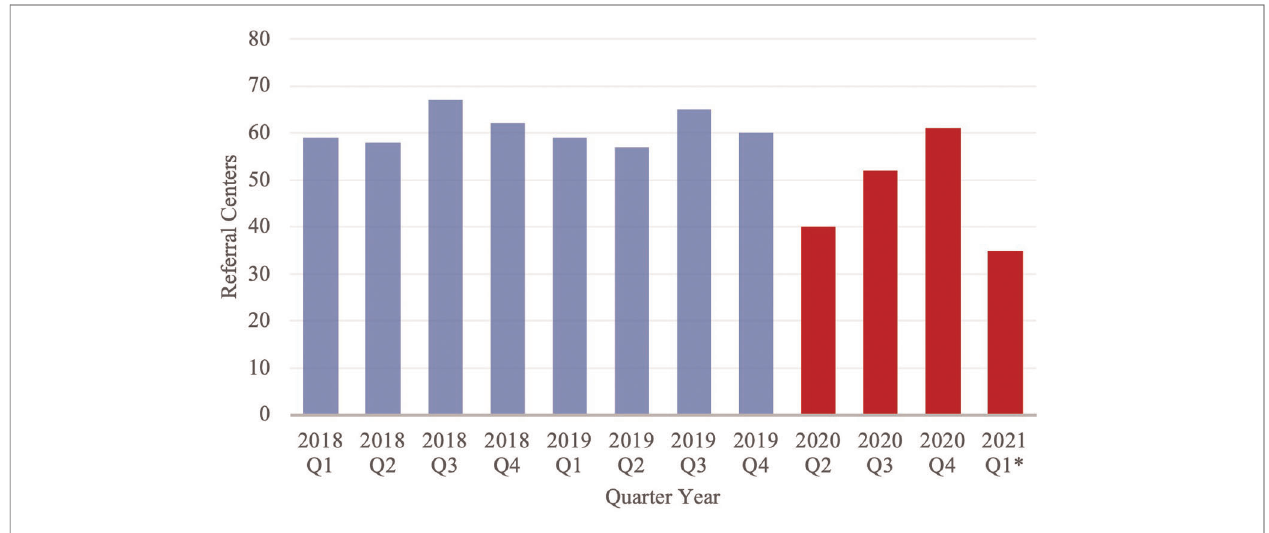
FIGURE 3 | Number of Referral Centers from which neuroemergent patients were transferred, strati fi ed by Quarter Year. Blue and red columns represent data from the PCOV and COVID cohorts, respectively. *Note: Data from 2020 Q1 has been excluded from the study; Data from 2021 Q1 only includes the months of January and